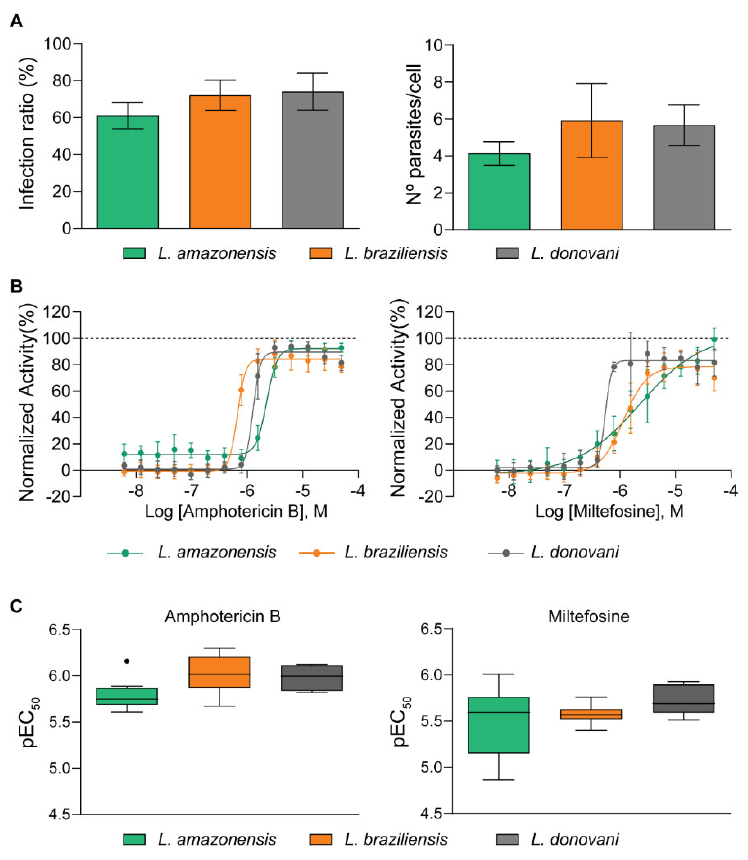
Figure 2. Leishmania high content assay parameters. ( A ) Quantitative parameters of Leishmania infection in terms of infection ratio (left) and the number of amastigotes / cells (right). ( B ) Concentration–e ff ect curves of the reference compounds amphotericin B and miltefosine against Leishmania species. The X -axis indicates the log of compound concentration (molar), and the Y -axis indicates the normalized antiparasitic activity, which represents the inhibition of infection in relation to controls. EC 50 values for amphotericin B were: 1.7 µ M for L. amazonensis ; 1.3 µ M for L. braziliensis ; and 0.7 µ M for L. donovani . EC 50 values for miltefosine were: 2.3 µ M for L. amazonensis ; 1.6 µ M, for L. braziliensis ; and 0.6 µ M for L. donovani . As indicated in legend: L. amazonensis (green), L. braziliensis (orange), and L. donovani (grey). ( C ) Boxplots of ten independently determined pEC 50 values of amphotericin B and miltefosine. The plot shows median (line within box), 25th and 75th percentiles (box), and minimum and maximum (whiskers). The black circle indicates an outlier.